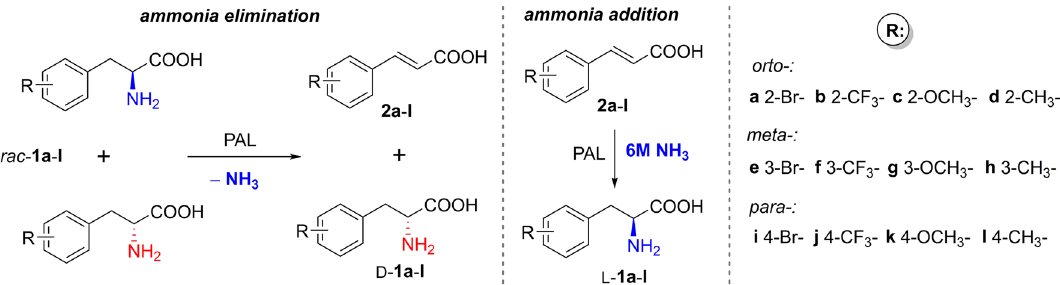
Figure 2. The activity assessment of the Rt PAL, At PAL and Pc PAL variant library within the deamination and amination reactions of phenylalanines rac - 1a–l and cinnamic acids 2a–l , monosubstituted at ortho-, meta-, para- positions of their aromatic